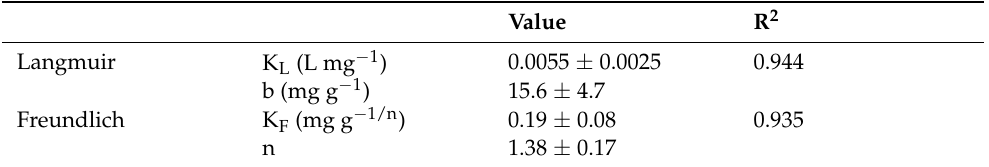
Table 2. Parameters of the Langmuir and Freundlich models.